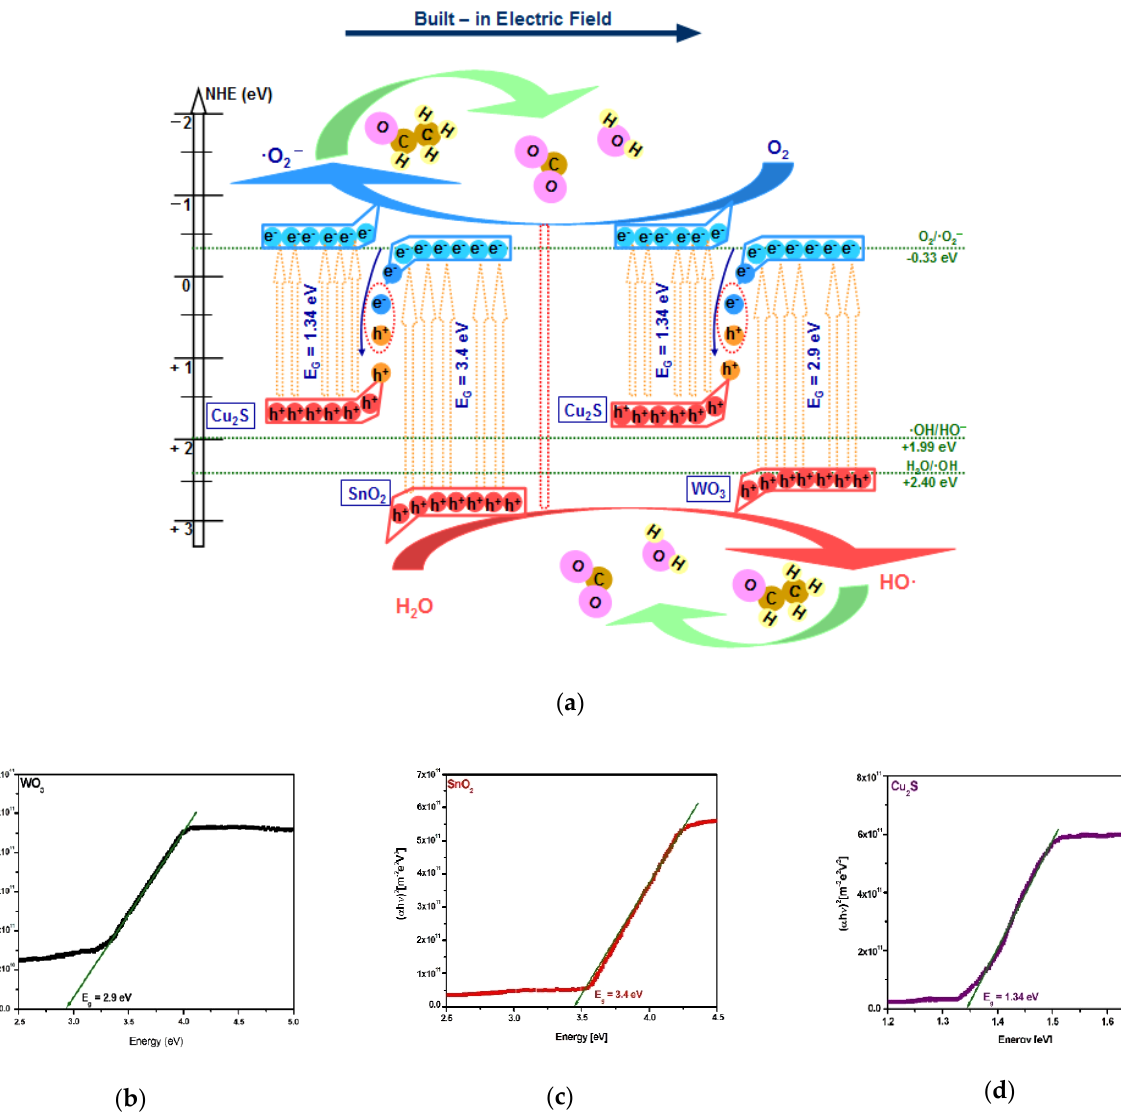
Figure 4. ( a ) Heterostructures’ Z-scheme mechanism and band-gap values of ( b ) WO 3 , ( c ) SnO 2 , and ( d ) Cu 2 S semicon- ductors.